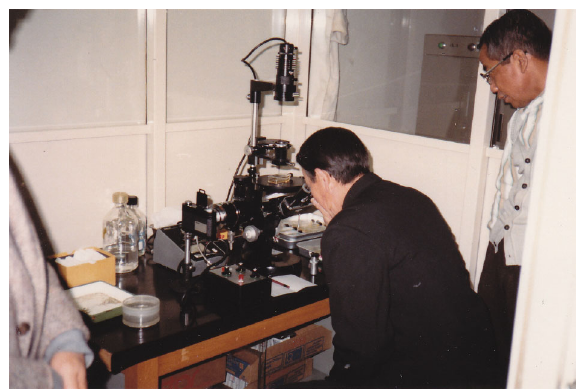
Figure 3. Prof. Duan was instructing students to use the electron